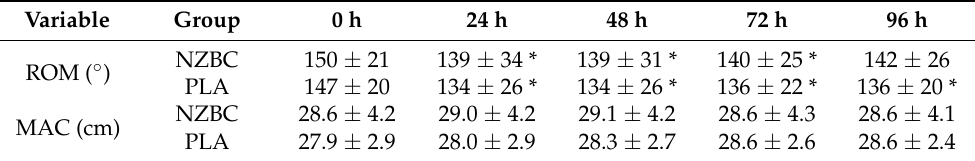
Table 3. Elbow range of motion (ROM) and mid arm circumference (MAC) in NZBC and Placebo groups before and after muscle damage Figure 3. Muscle soreness before and after eccentric exercise in the PLA and NZBC groups. Values are means ± SEM, * significant difference between groups ( p < 0.05).